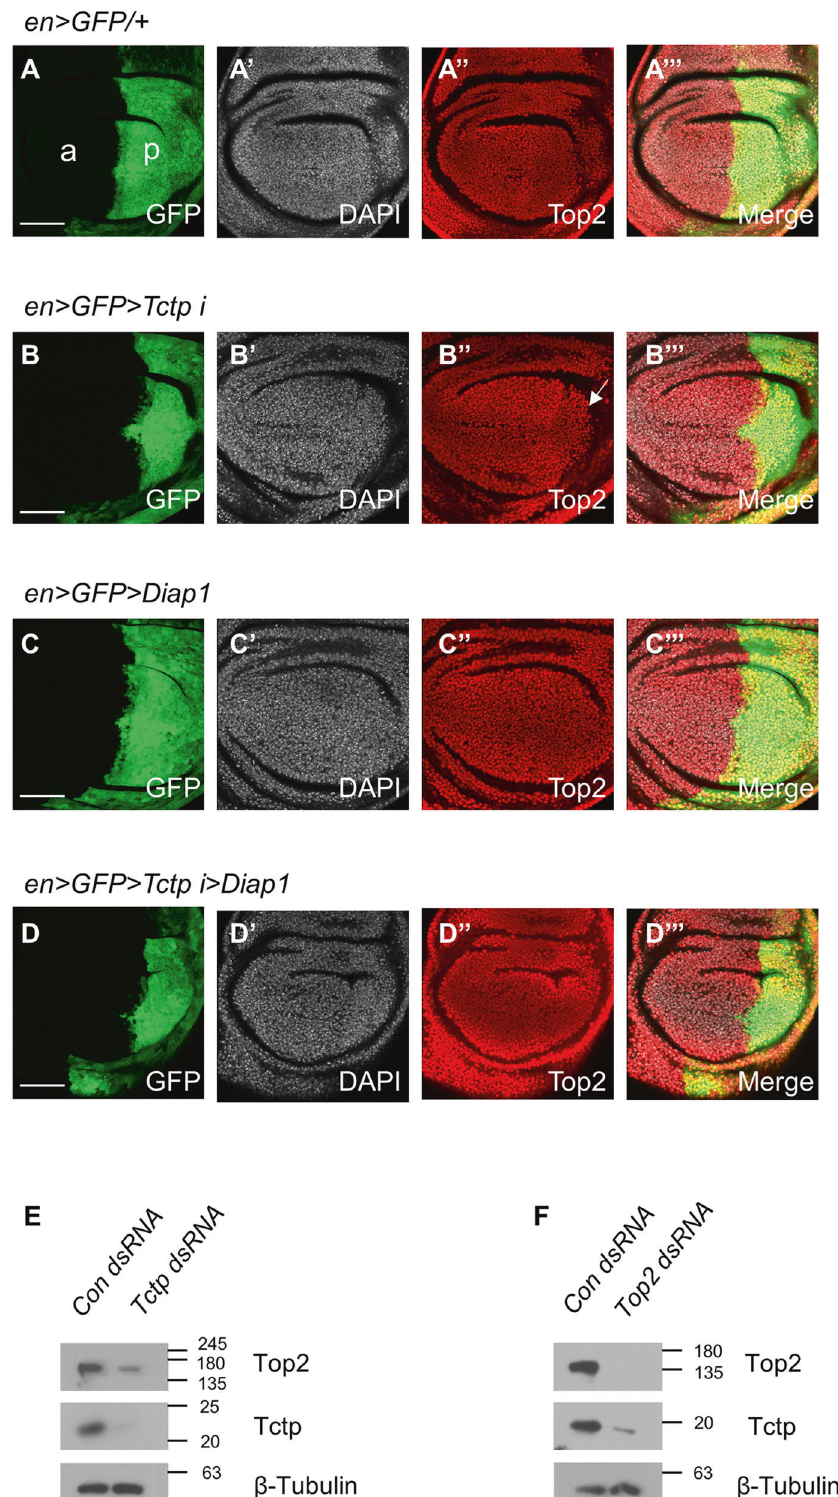
Fig. 5 Tctp RNAi reduces Top2 protein levels. A – A ’’’ en > GFP/ + shows no signi fi cant change in the Top2 level in the posterior domain at 25 °C. A GFP, ( A ’ ) DAPI, ( A ’’ ) Top2, ( A ’’’ ) Merge. Scale bars in ( A – D ) are 50 µm. B-B ’’’ en > GFP > Tctp i shows a decrease in Top2 level at 25 °C. (11/ 14 discs; 78.6%) ( B ) GFP, ( B ’ ) DAPI, ( B ’’ ) Top2, ( B ’’’ ) Merge. The white arrow shows an area of decreased Top2 in the posterior region. C – C ’’’ en > GFP > Diap1 shows little change in the Top2 level at 25 °C. ( C ) GFP, ( C ’ ) DAPI, ( C ’’ ) Top2, ( C ’’’ ) Merge. D – D ’’’ en > GFP > Tctp i > Diap1 shows rescue of Top2 level at 25 °C (8/12 discs; 75%). D GFP, ( D ’ ) DAPI, ( D ’’ ) Top2, ( D ’’’ ) Merge. E , F Western blots stained for Top2, Tctp, and β -Tubulin. ( E ) Top2 protein level is decreased in Tctp-depleted S2 cells (representative of three independent experiments). F Tctp protein level is decreased in Top2-depleted S2 cells (representative of three independent